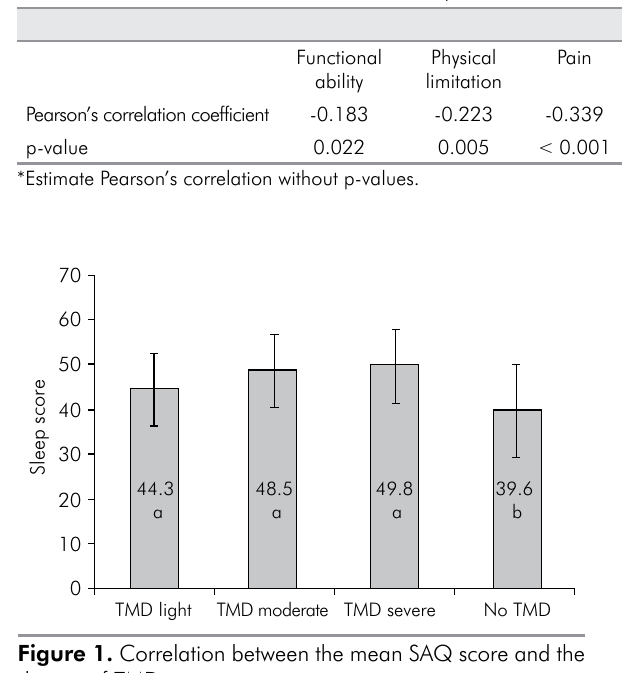
Table 5. Association between the Fonseca’s questionnaire score and the score on each domain of the SF-36.